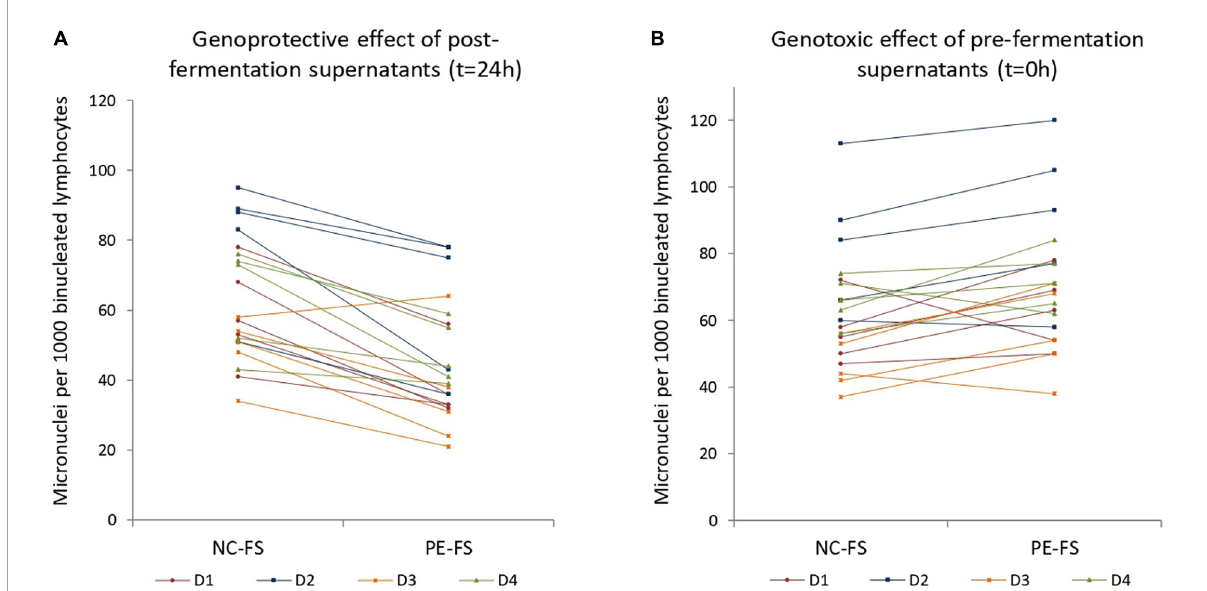
FIGURE1 Genoprotective and genotoxic effects of (A) post- and (B) pre- fermentation supernatants in human lymphocytes. Human peripheral blood cells were treated with 1% v/v post- and pre- fermentation supernatants of NC and PE in combination with the mutagenic agent mitomycin C. Micronuclei formation was evaluated in 1,000 binucleated lymphocytes for each blood and fecal donor. (A) Genoprotective effect of 1% v/v post- fermentation supernatants of PE per blood and fecal donor ( t = 24 h); (B) genotoxic effect of 1% v/v pre- fermentation supernatants of PE per blood and fecal donor ( t = 0 h). NC-FS, fermentation supernatants without any additional carbon source; PE-FS, fermentation supernatants of Pleurotus eryngii mushroom; D1–D4, blood